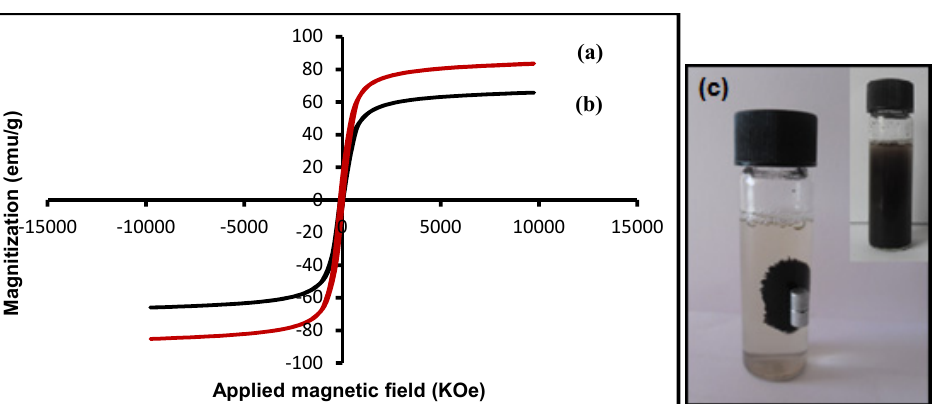
Figure 11. Magnetization curves of ( a ) Fe separation of magnetic nanoparticles under an external magnetic field.